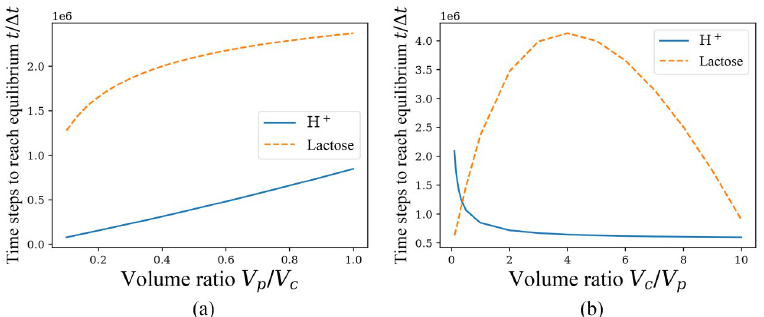
periplasm and cytoplasm, which has the initial conditions n